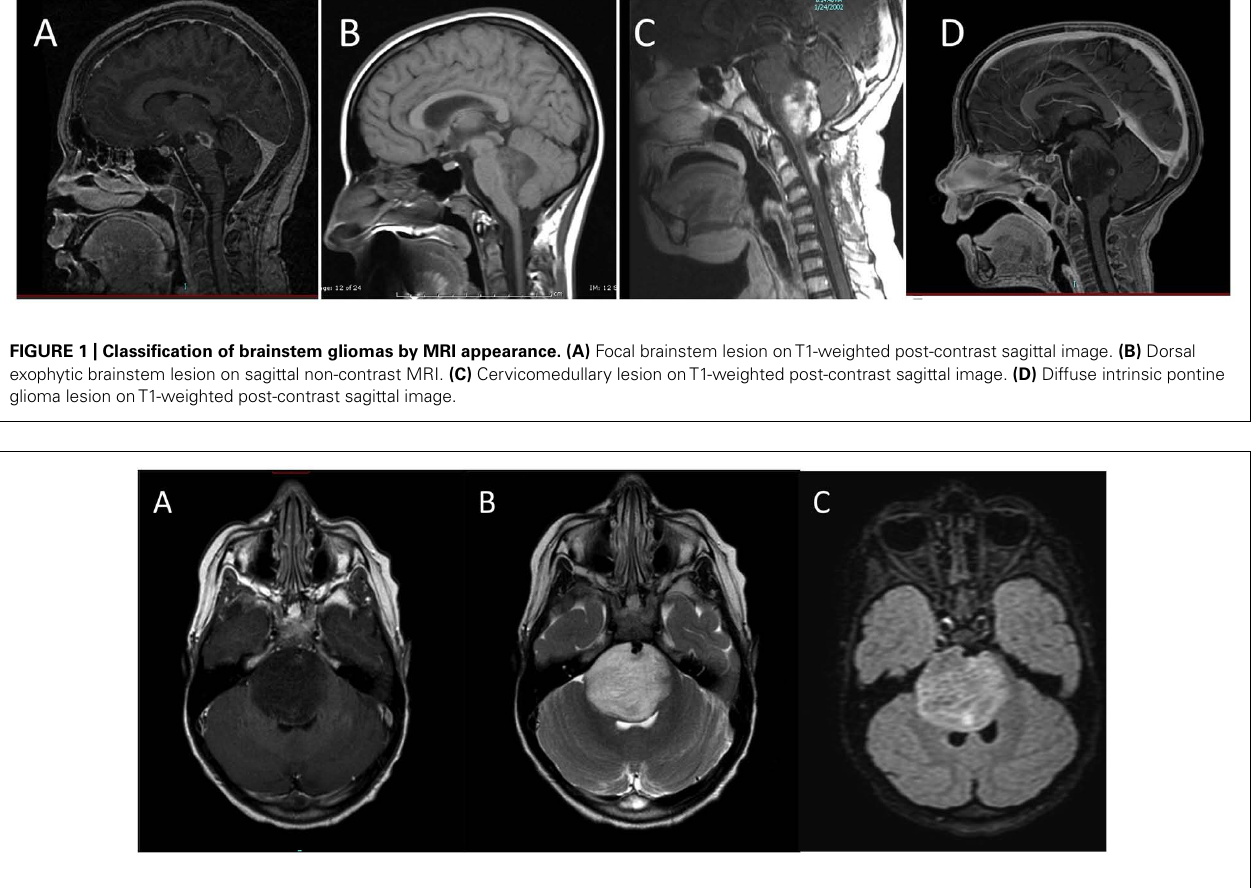
hypo- or iso-intense on T1- weighted imaging, hyperintense on T2-weighted imaging, and frequently appear relatively homoge- neous on fluid attenuated inversion recovery (FLAIR)